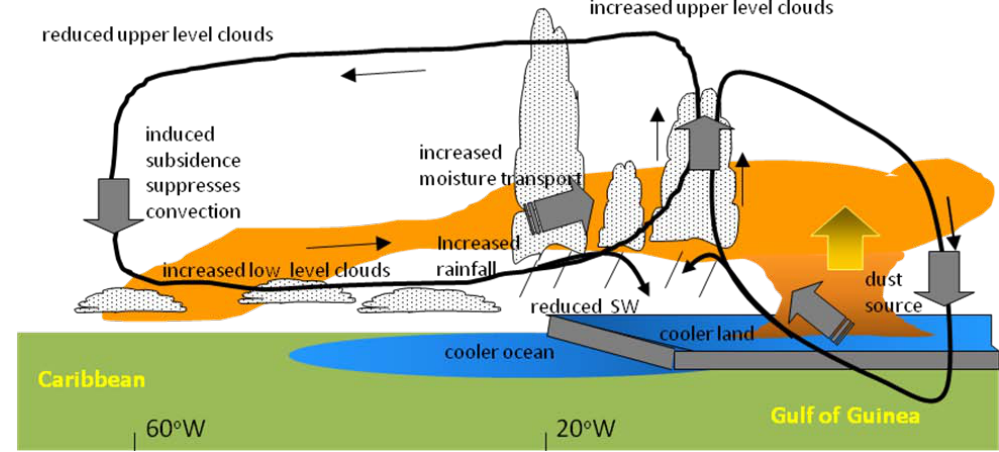
Fig. 10. Schematic diagram showing Saharan dust induced anomalous Walker-type and Hadley-type circulations, and accompanying changes in components of the atmospheric water and energy cycle, across West Africa, the Atlantic and the Caribbean, over the latitude domain 5 o N – 15 o N.